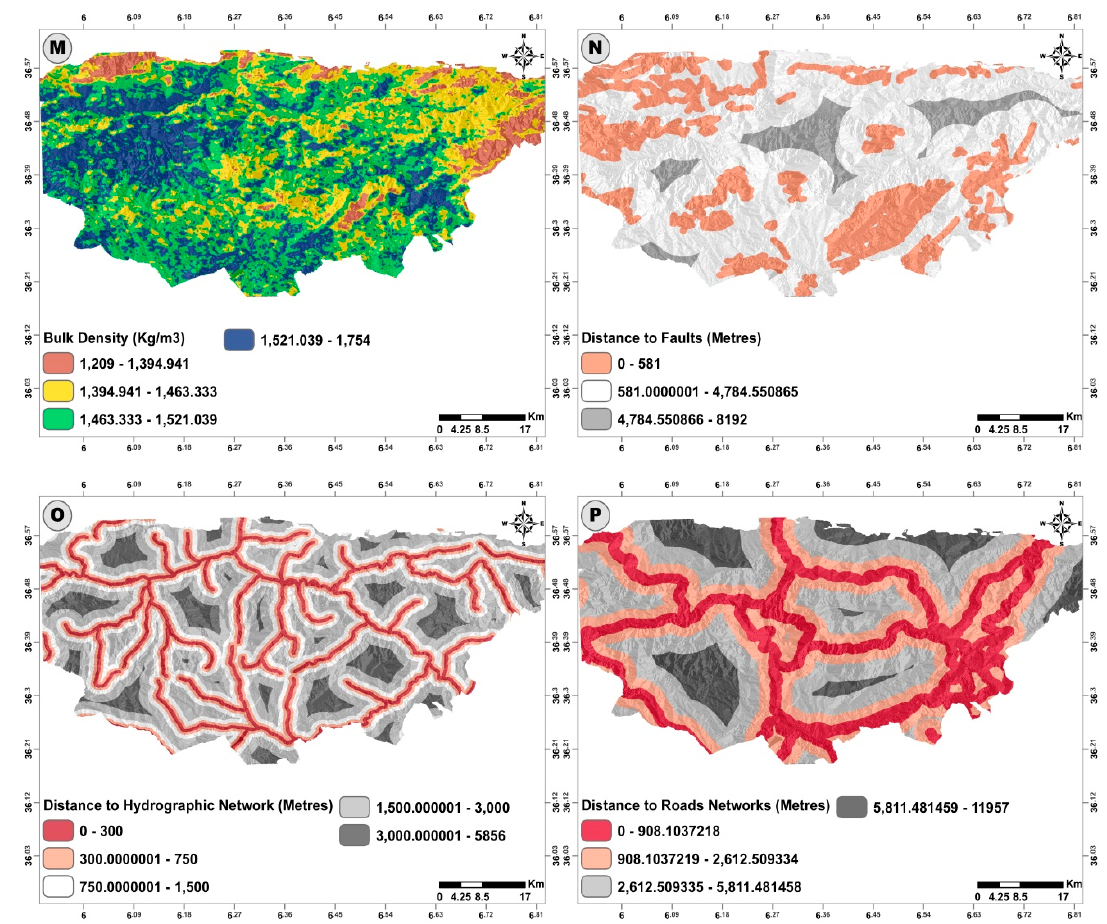
Figure 4. The landslide conditioning factors maps: ( A ) altitude, ( B ) slope, ( C ) aspect, ( D ) Topographic Wetness Index (TWI), ( E ) landforms, ( F ) rainfall, ( G ) lithology, ( H ) stratigraphy, ( I ) soil type, ( J ) soil texture, ( K ) land use, ( L ) depth to bedrock, ( M ) bulk density, ( N ) distance to faults, ( O ) distance to hydrographic network, and ( P ) distance to road networks.